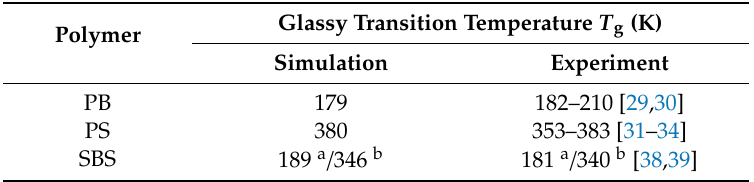
Table 3. Glass transition temperatures ( T g ) by MD simulations and experiments